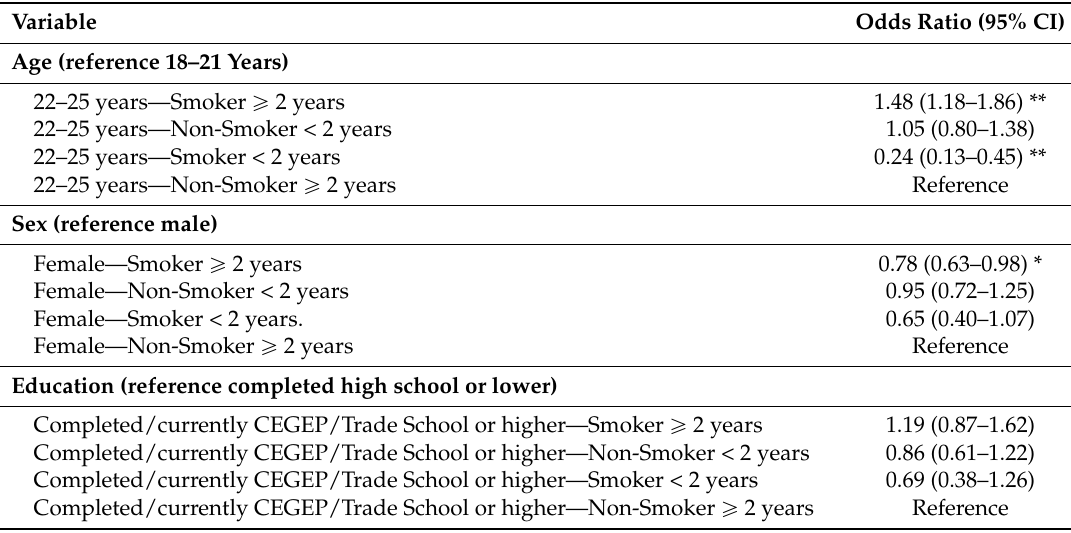
Table 2. Results of multinomial multilevel regression models predicting smoking trajectory over 2 years from individual-level exposures among 2070 young adults living in Montreal, Canada in